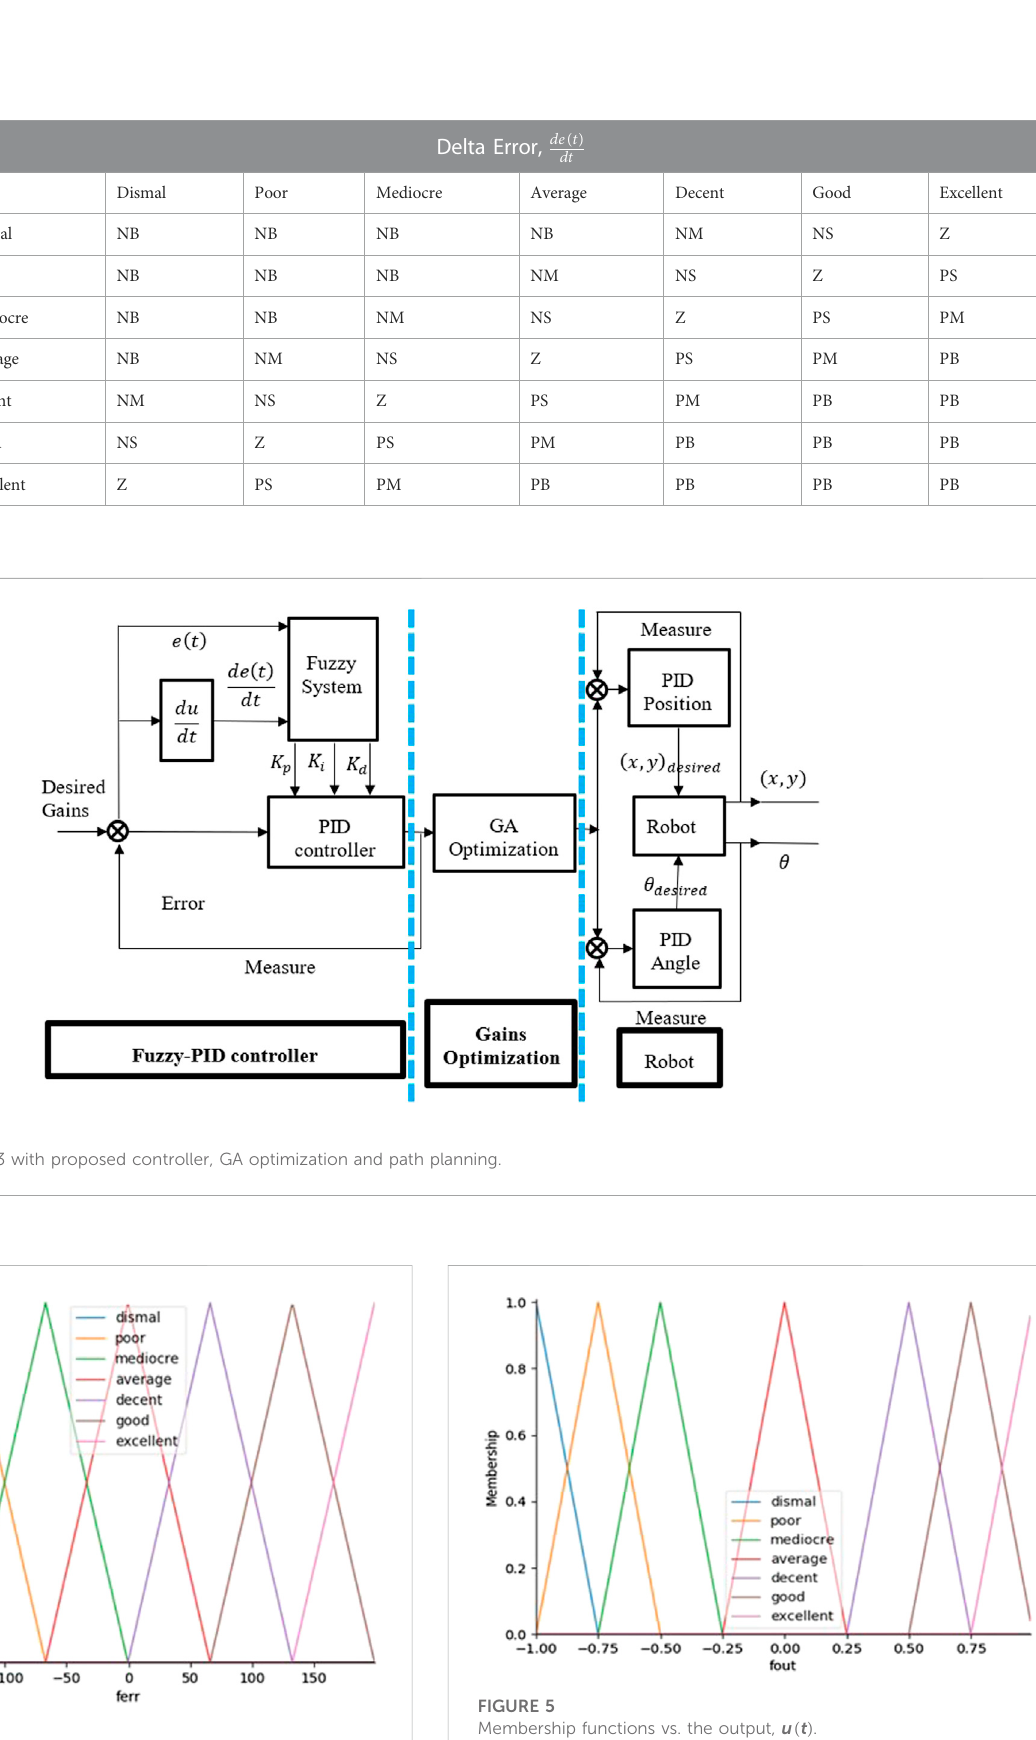
FIGURE 4 Membership functions vs. the error, e ( t ) .